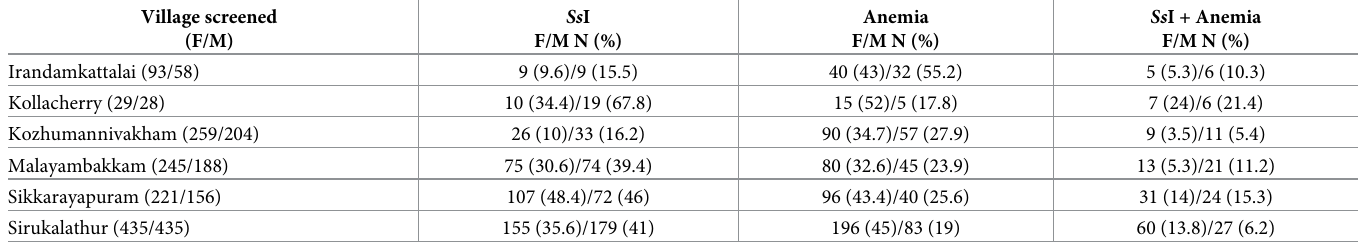
Table 4. Prevalence of Anemia and Stongyloides stercoralis infection. Village screened (F/M)